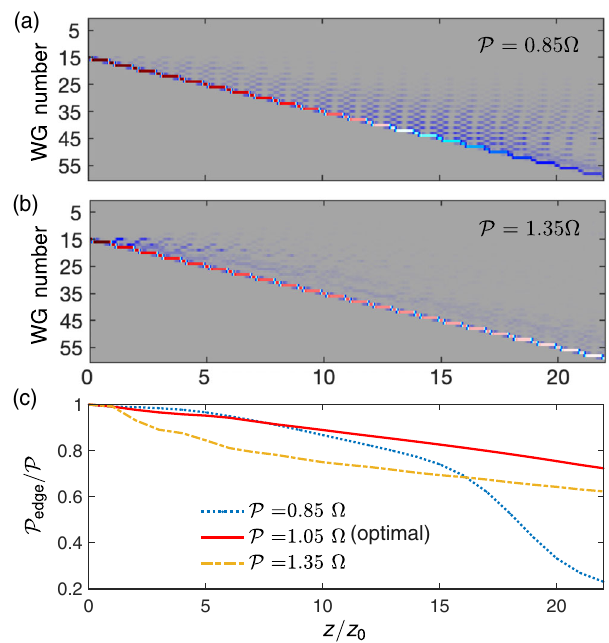
FIG. 7. Nonlinear edge states near the power value associated with the IPR peak. (a),(b) Propagation of a single-site input wave packet on the edge of the periodically driven lattice ( δ ¼ 0 . 18 ) with two different renormalized powers P indicated in each plot. The optimal solitonlike propagation of the nonlinear edge state with minimal radiation (i.e., with the longest lifetime) is asso- ciated with the IPR peak; see Fig. 2(b) and the solid red line in (c). As shown in (a) and (b), there exist similar nonlinear states with excess radiation near (i.e., before and after) the IPR peak. (c) The variation of the fraction of total normalized power on the zigzag edge, for different values of renormalized powers indicated in the